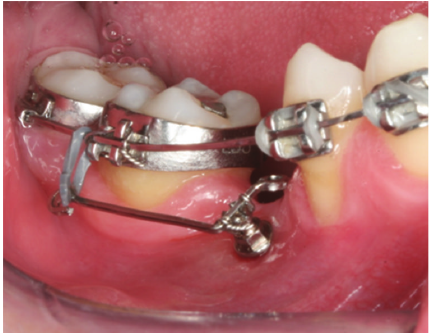
Figure 8: Counterclockwise orthodontic implant thread with bracket